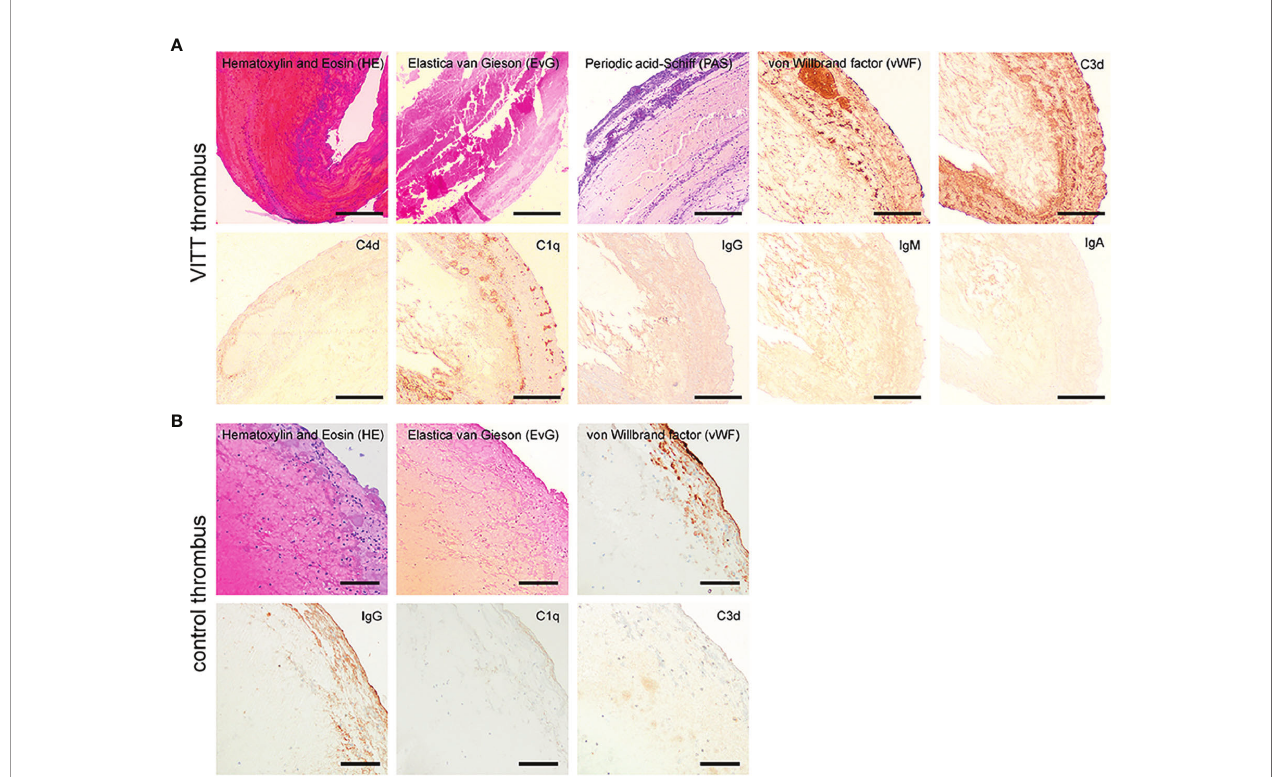
FIGURE 1 | Histopathological examination of the VITT-thrombus and a control. (A) On conventional histology the VITT-thrombus displayed a mixed content of erythrocyte rich (red in H&E) and platelet rich areas (purple in PAS-reaction) without signs of organization or parts of vessel walls in a staining for connective tissue (EvG). On further investigation via immunohistochemistry (dark brown coloration = positive signal), the thrombus showed areas of increased content of von Willebrand-factor as seen in other thrombi. Further, presence of complement factors C1q and C3d alongside a faint positive staining for IgG-immunoglobulin was present, while IgM, IgA and C4d could not be detected in the thrombus material. Magni fi cation 40x, scale bar 300µm. (B) On conventional histology, the control thrombus of a stroke patient from the cohort displayed a mixed content of erythrocyte rich (H&E staining) and platelet rich areas without signs of organization or parts of vessel walls in a staining for connective tissue (EvG) comparable to the VITT- thrombus. On further investigation via immunohistochemistry (dark brown coloration = positive signal) the thrombus showed a comparable increase of von-Willebrand-factor and IgG-Immunoglobulin as described for the thrombus in (A) However, no presence of complement factors C1q and C3d could be detected. Magni fi cation 100x, scale bar 100µm.